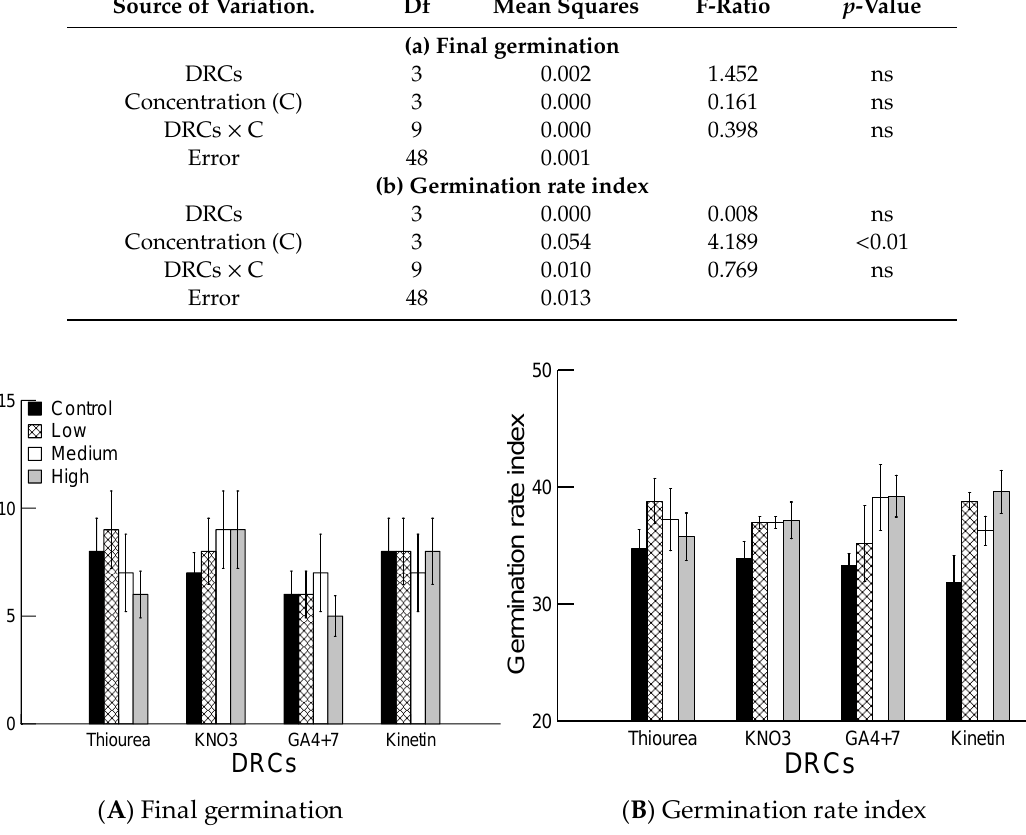
Figure 4. Effect of different concentrations of different dormancy regulating compounds (DRCs) on ( A ) final germination percentage and ( B ) germination rate index (mean ± SE) of dehusked-demembraned grains of Brachypodium hybridum . Low, medium and high concentrations were 5, 10 and 15 mM for thiourea, KNO 3 , 0.25, 0.5 and 0.75 mM for GA 4+7 and 0.05, 0.25 and 0.5 mM for Kinetin, respectively.